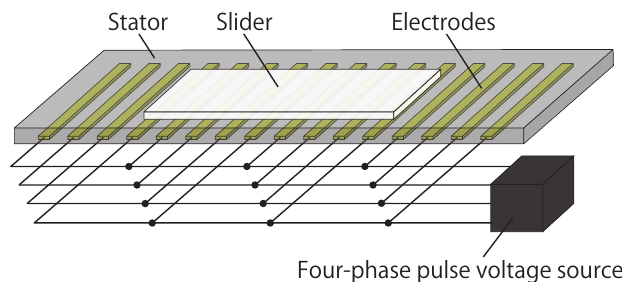
Figure 1. Structure of charge-induction electrostatic linear actuator with a four-phase